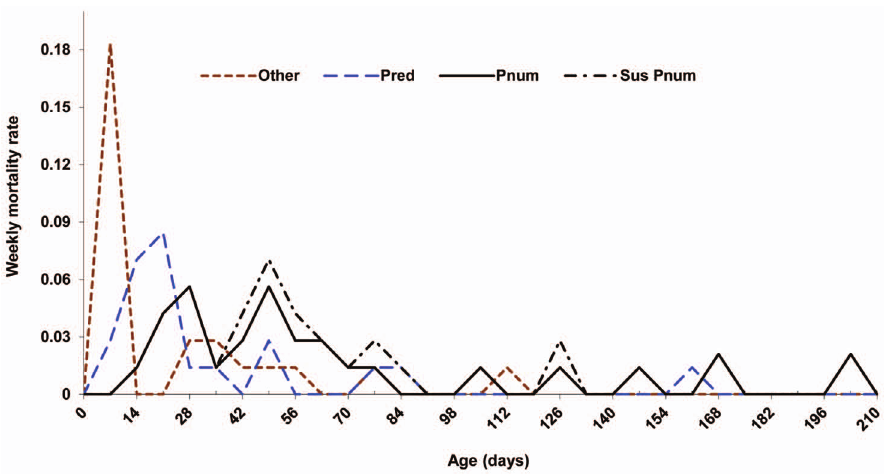
Figure 2. Average weekly mortality rate comparison of bighorn lamb mortality events. Average weekly mortality rate comparison for other a , predation, pneumonia, and suspected pneumonia b mortality events of bighorn lambs in the Black Hills, South Dakota, USA, 2010–2012. a Other includes all causes of mortality other than predation and pneumonia. b Suspected pneumonia includes mortalities in which we assumed pneumonia was the ultimate or proximate cause of death in addition to confirmed pneumonia mortality events.